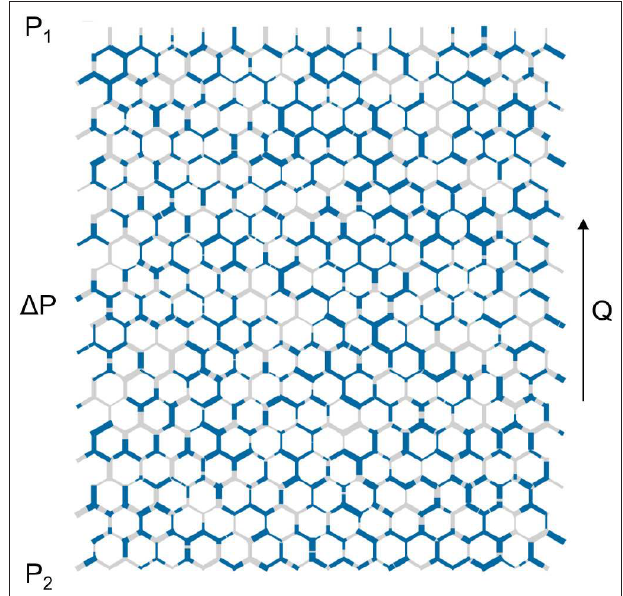
FIGURE 1 | Illustration of the network model. The network is occupied by two immiscible fluids (blue and gray colors). The equally long links (pores) have an hourglass-shaped structure and a random distribution of